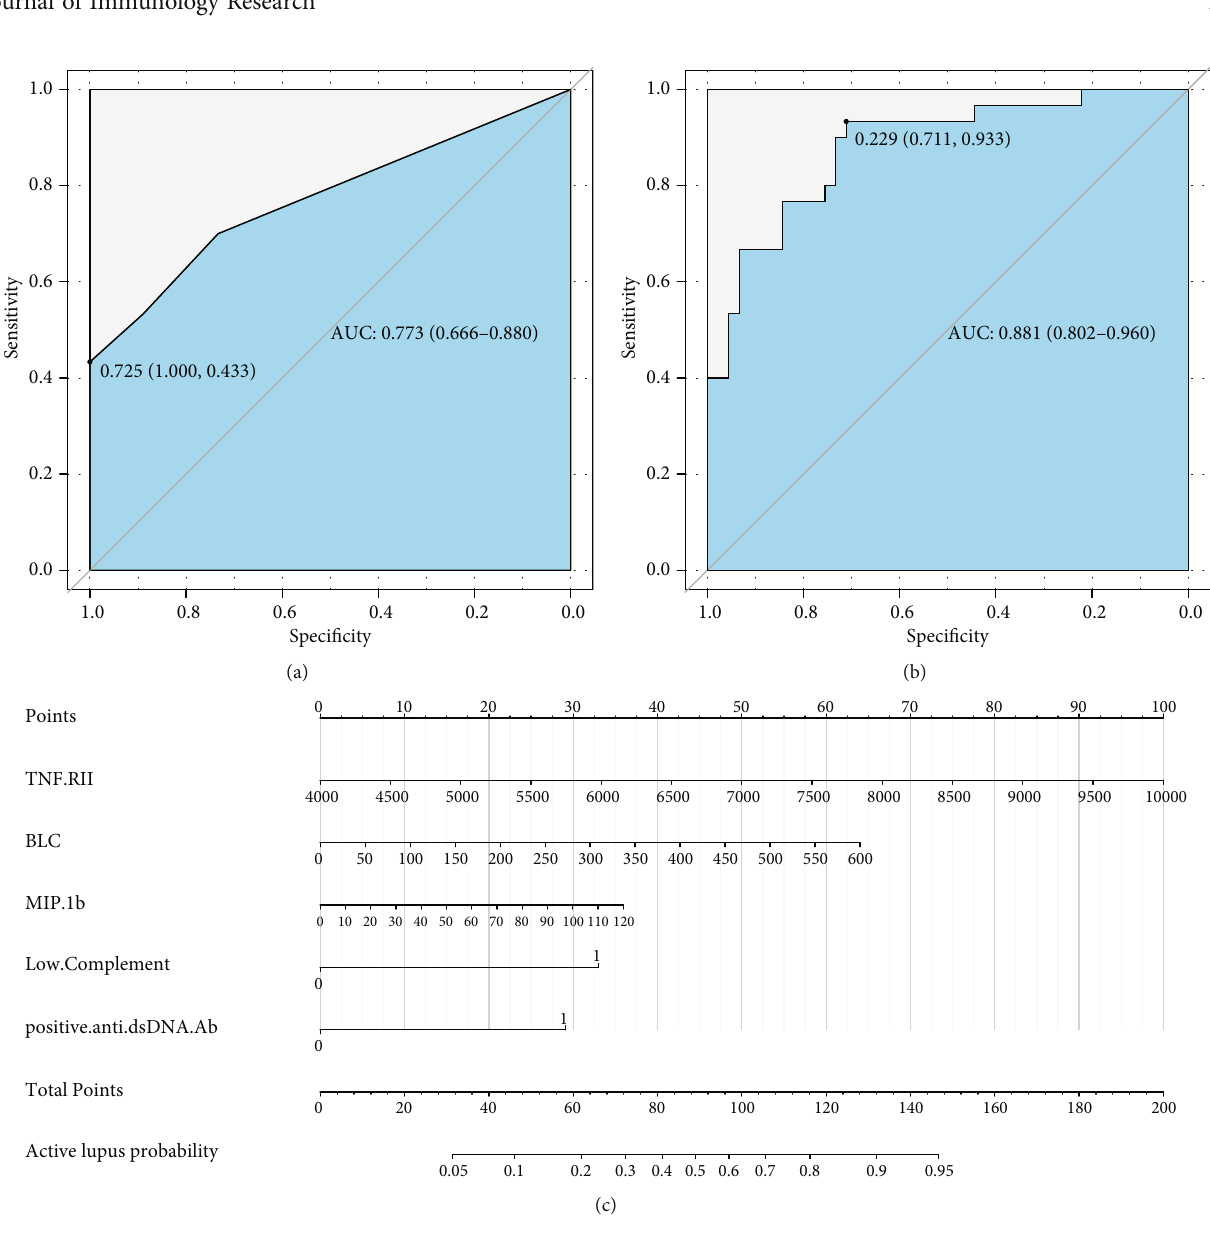
Figure 4: Additional value of our biomarkers based on conventional biomarkers. (a) Conventional biomarkers in predicting active lupus. (b) ROC of combined factors in predicting active lupus. (c) Nomogram of combined activity diagnosis